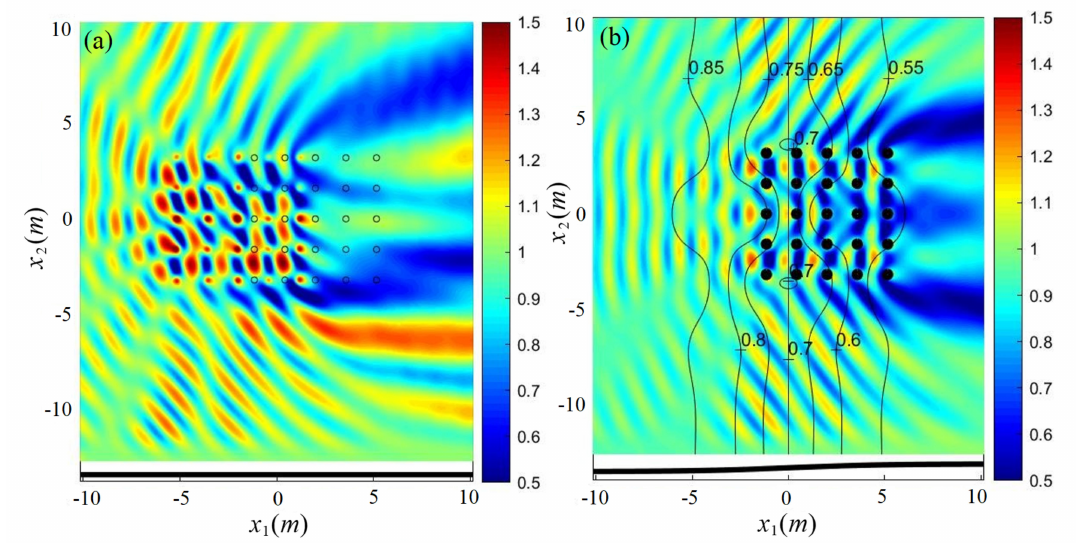
Figure 14. Same as in Figure 13 for the 5 × 5 WEC arrangement modelled by inclusions in the case of ( a ) obliquely incident waves at an angle of 15 deg in constant depth, and ( b ) waves over the sloping seabed bathymetry of 4% with additional irregularities (shown by the depth